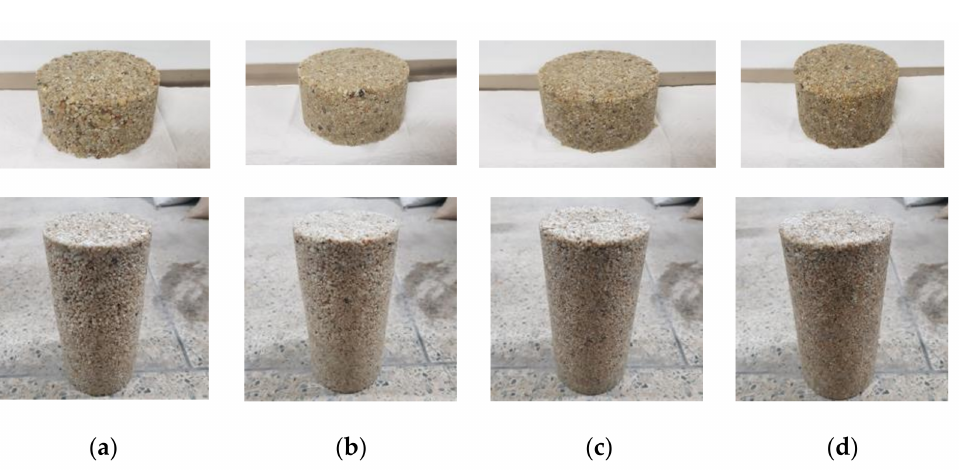
Figure 2. Fabricated test specimens for the (top) water permeability and (bottom) compressive strength tests: ( a ) G33, ( b ) G47, ( c ) G60, and ( d )